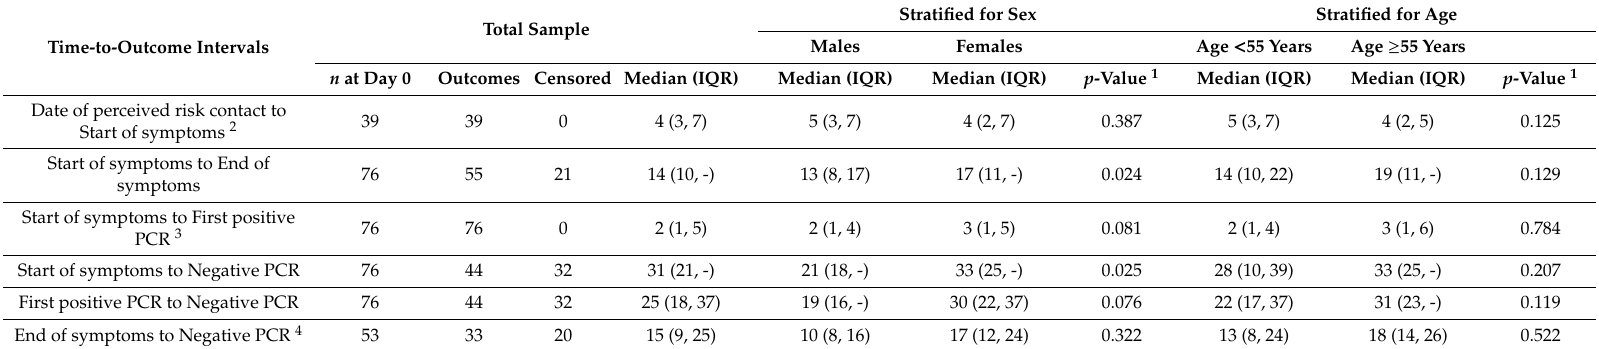
Table 3. Median times for the main